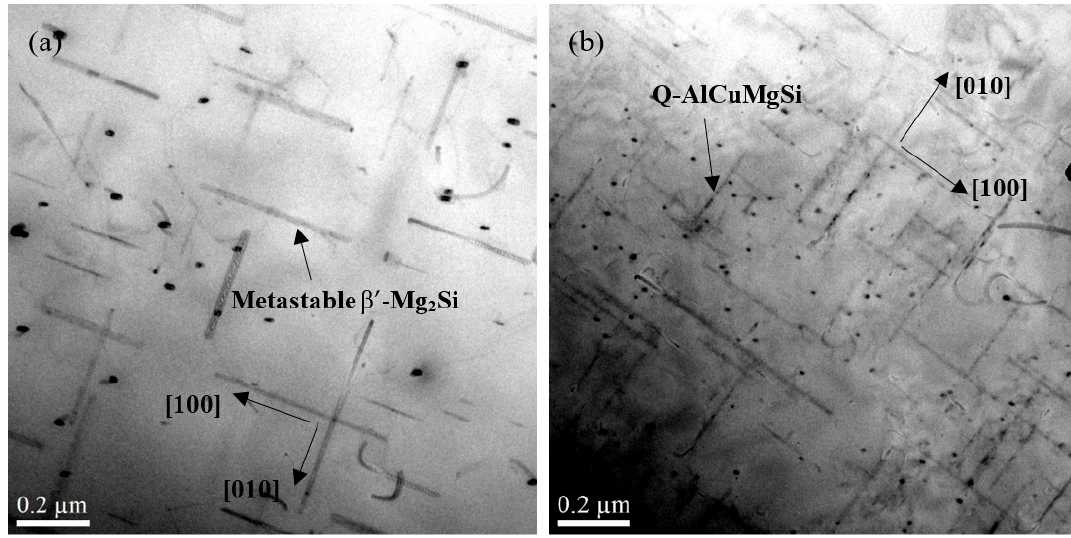
Figure 8. TEM images of as-heated 330 °C samples followed water quenching: ( a ) DU0 alloy and ( b ) DU120 alloy.